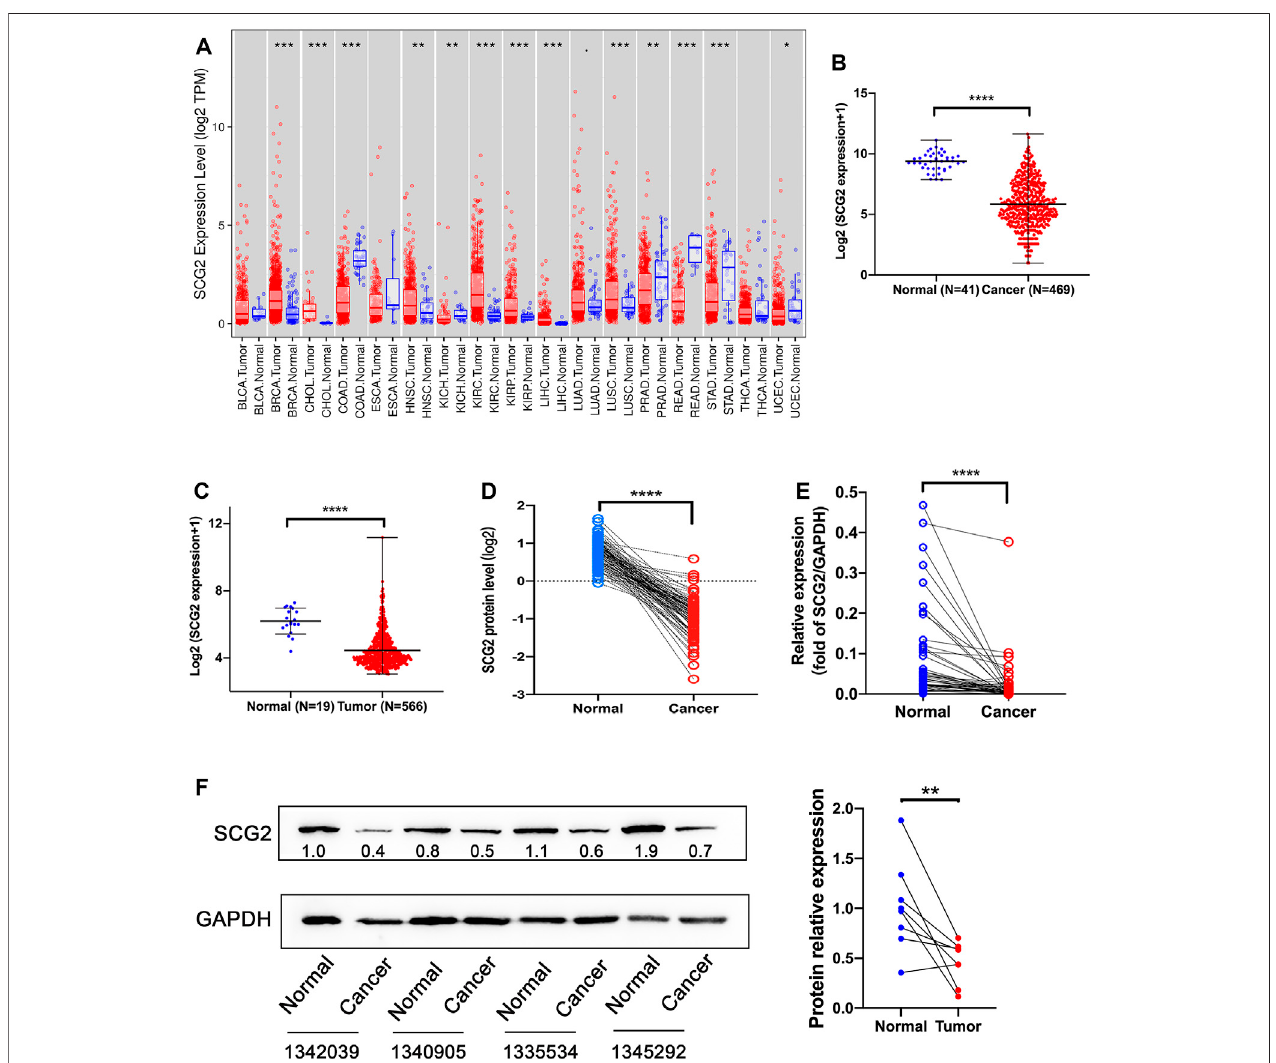
FIGURE 1 | Expression analysis of SCG2. (A) The SCG2 expression level in multiple cancer types from TCGA database. (B,C) SCG2 mRNA expression levels in normal and tumor tissues of CRC from TCGA and GEO database. (D) SCG2 protein levels in 96 paired CRC tissues from CPTAC. (E) SCG2 mRNA expression level in tumor and adjacent samples. (F) Quanti fi cation of SCG2 protein expression in tumor and adjacent samples. (A – C) Examined by Mann-Whitney U test; (D – F) Examined by Wilcoxon signed rank test; * p < 0.05, ** p < 0.01, *** p < 0.001, **** p < 0.0001.